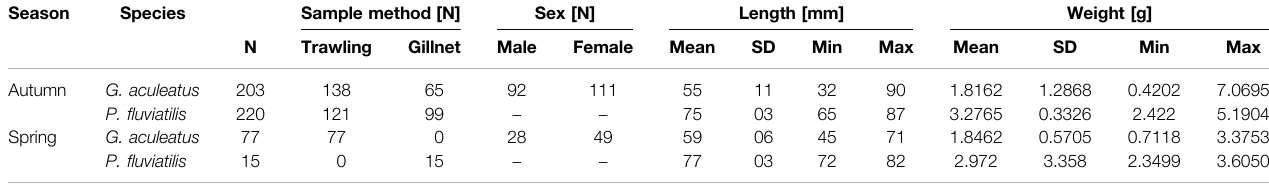
TABLE 1| Numberand morphometricsofsticklebacks( G.aculeatus )and perch( P. fl uviatilis )used forthestomachcontentanalysisperspeciesand season.Intotal,280 G. aculeatus and 235 P. fl uviatilis from Lake Constance were analyzed for both seasons. Season Species